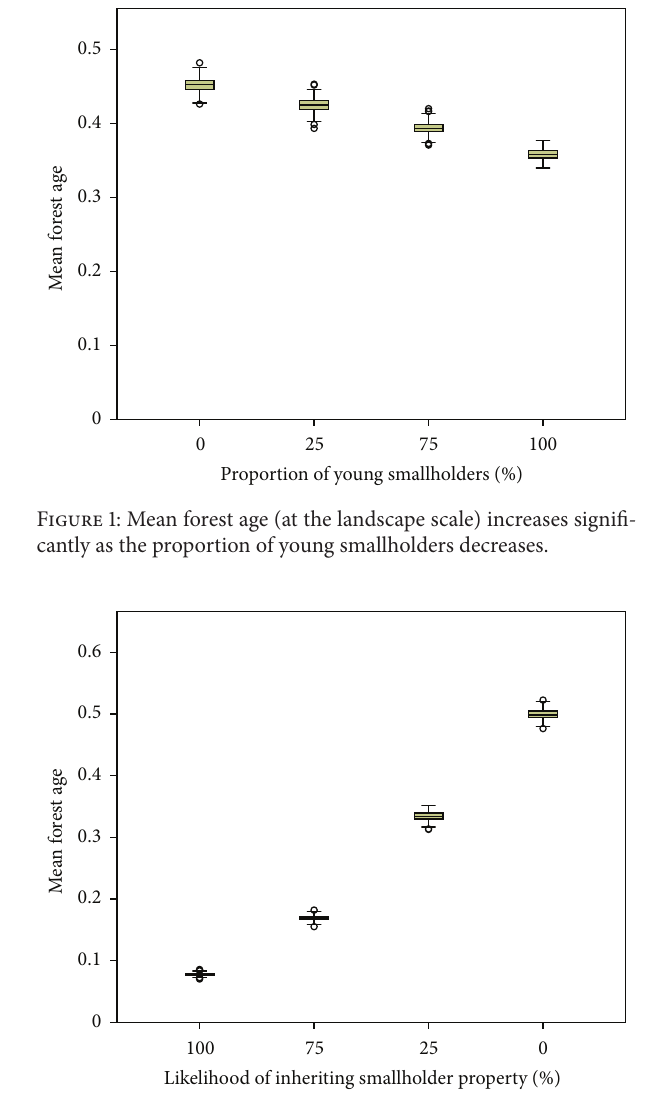
Figure 2: Mean forest age (at the landscape scale) increases sig- nificantly with decreasing likelihood of inheriting one’s smallholder